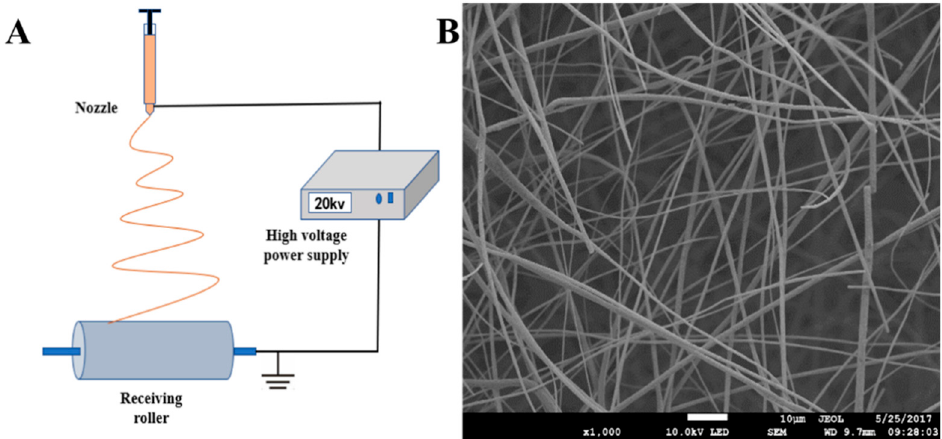
Figure 4. ( A ) Schematic illustration of electrospinning and ( B ) SEM image of TiO 2 nanofibers prepared by electrospinning.